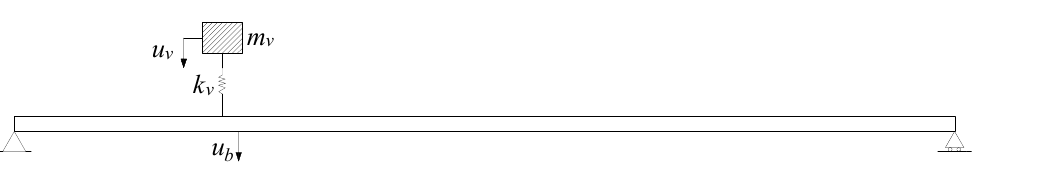
Figure 2. Lumped sprung mass moving on a simply supported beam.